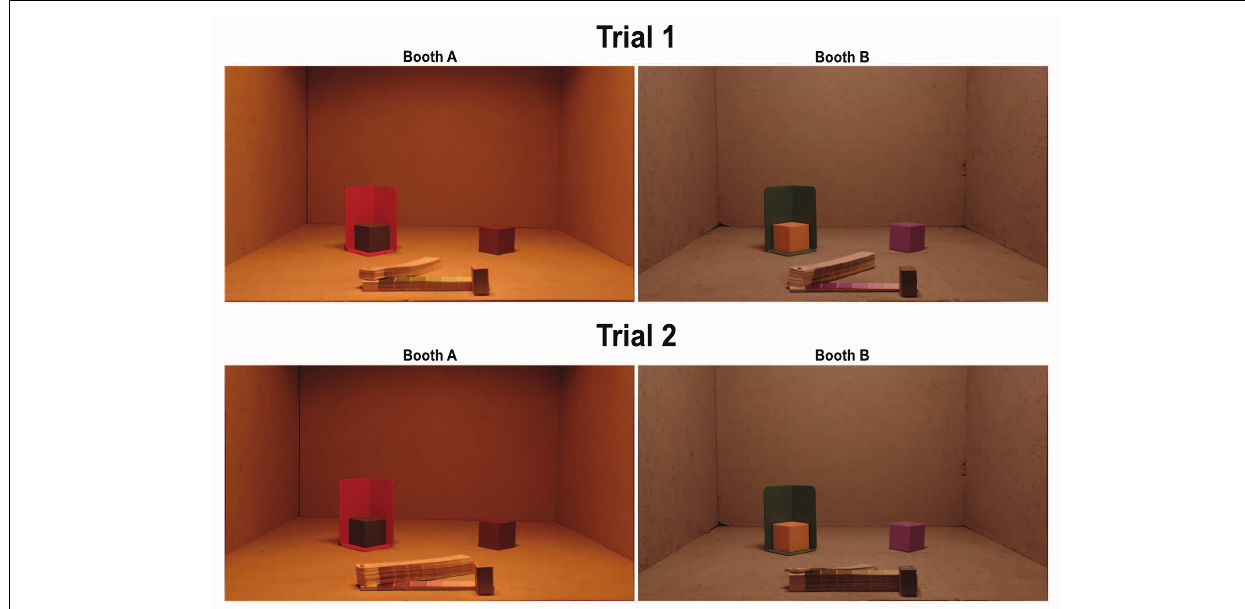
FIGURE 2 | Photograph of experimental setup for one example trial. On each trial, observers viewed four cubes, two cubes each in Booth A (left images) and Booth B (right images) that were separately illuminated. On each trial, one cube in each booth was embedded in a 3D background (for this condition, left cubes in each image). The matching palette (booklet in the front of each booth) contained 1022 paint chips. The palette in each booth rotated freely on a long screw mounted into palette, and the wooden stopper prevented observers from pulling palette strips out of the booth. Observers were permitted to flip freely through the book, but were instructed to choose